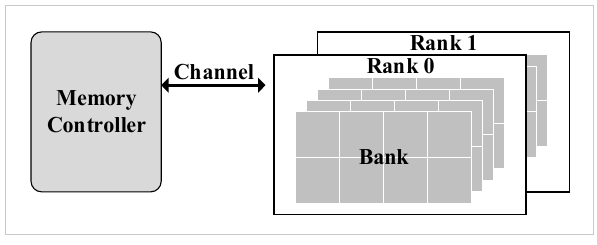
Figure 1. Dynamic random access memory (DRAM) hierarchical organization.